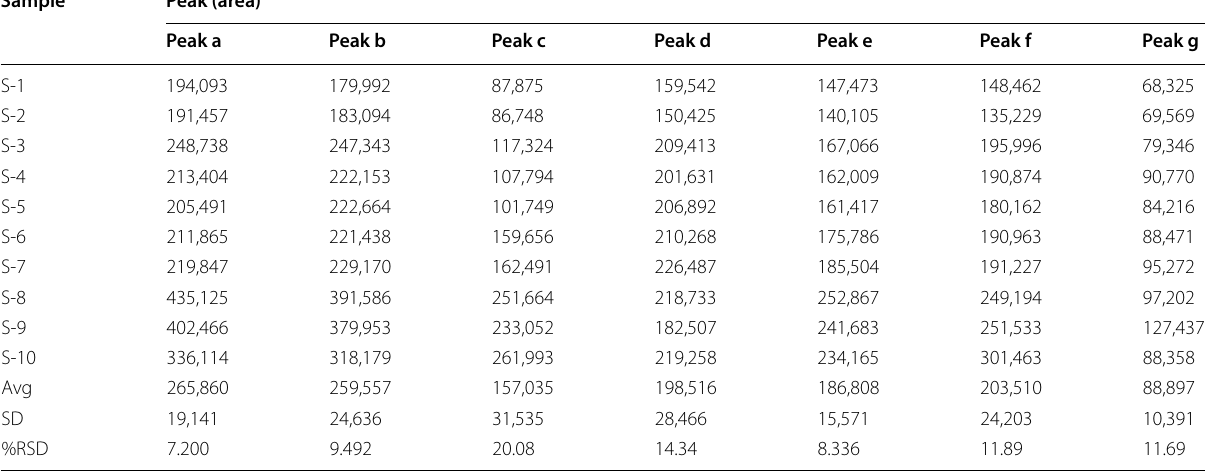
Table 4 Standard chemical profile for similarities assessment